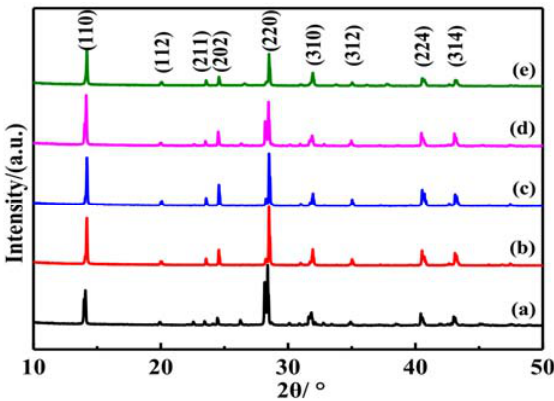
Figure 4. The XRD pattern of perovskite thin films with different ratios of DMSO ( a ) 0%; ( b ) 5%; ( c ) 10%; ( d ) 15%; ( e ) 20%. ( c ) 10%; ( d ) 15%; ( e )